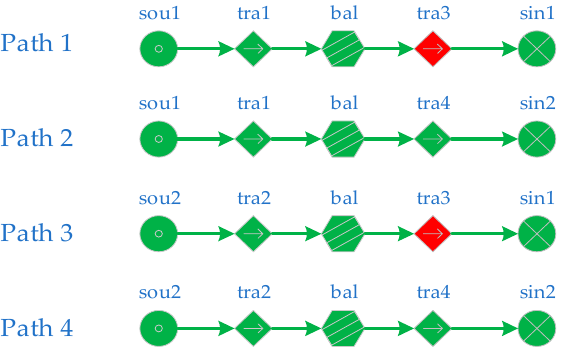
Figure 5. Identi fi ed success paths. Figure 5. Identified success paths.